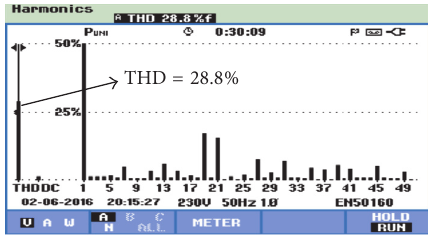
Figure 11: Output voltage THD for PD technique.